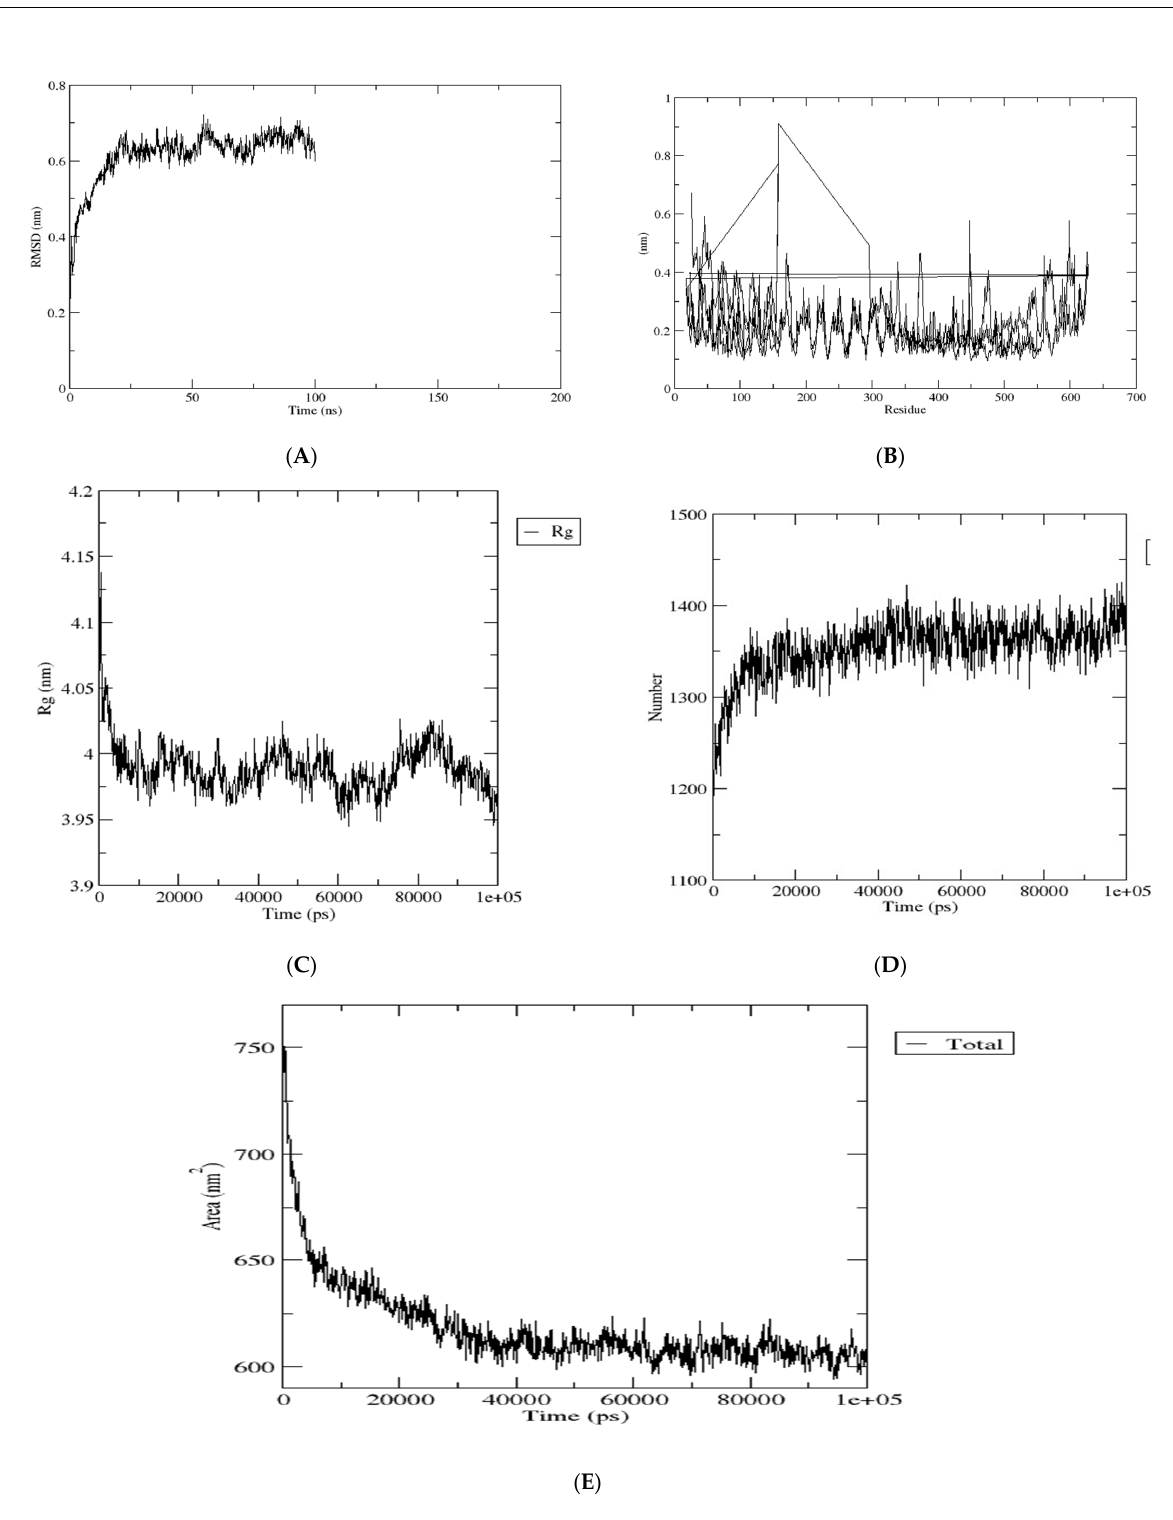
Figure 11. ( A ) RMSD study plot for 100 ns MD simulation of vaccine–TLR. ( B ) RMSF study plots for 100 ns MD simulation. ( C ) Radius of gyration study plot for 100 ns MD simulation vaccine–TLR. ( D ) Solvent accessible surface area study plot for 100 ns MD simulation of vaccine–TLR. ( E ) Solvent accessible surface area study plot for 100 ns MD simulation of vaccine–TLR.